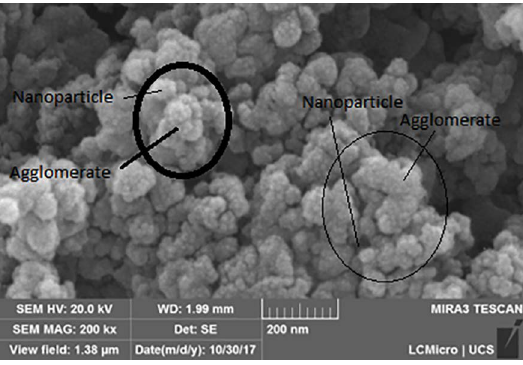
O @C nanoparticles. 3 4